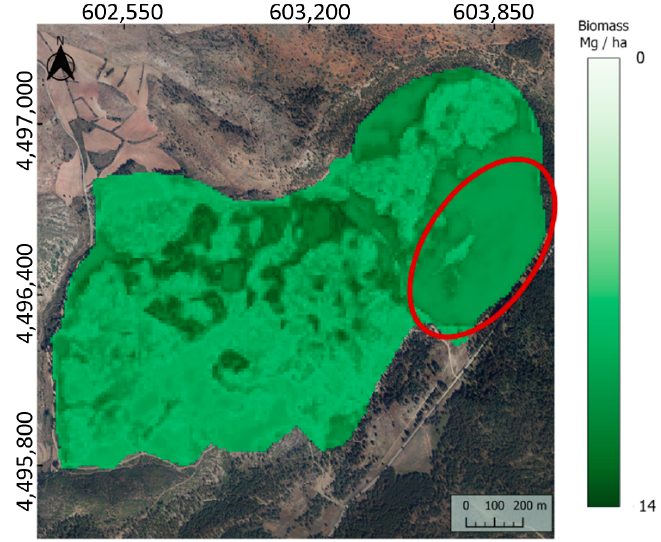
Figure 7. Application of the general algorithm over both a young oak coppice and a mature forest of Pinus sylvestris L. without class segmentation in the area of the Chequilla fire, June 2020. Inside the red circle, there is a mature forest of Pinus sylvestris L. with a remarkable underrating of biomass. GPR gave underrated values of biomass for a homogeneous mature forest of Pinus sylvestris L. When a specific algorithm for young oak coppice was applied over another forest structure, it was not able to distinguish the species, the structure, or the biomass